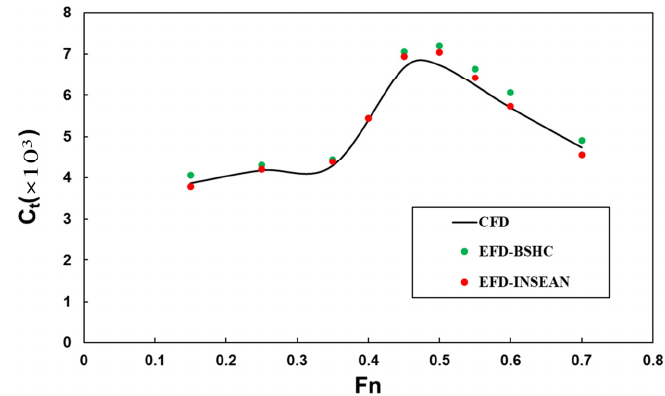
Figure 9. Comparison of the resistance coefficient between CFD and EFD results.